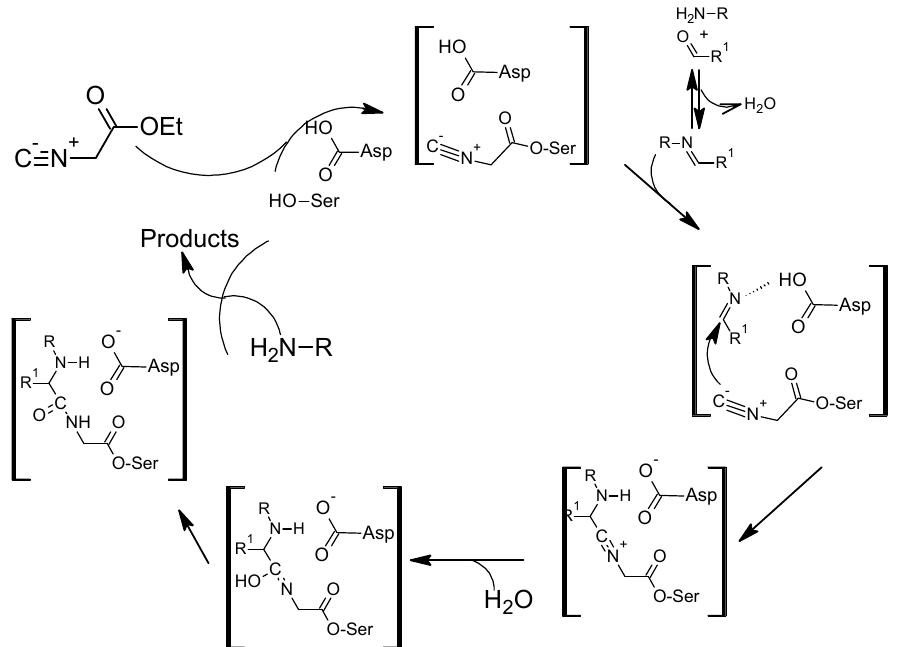
Scheme 18. Mechanism of the enzyme-catalyzed Ugi reaction.